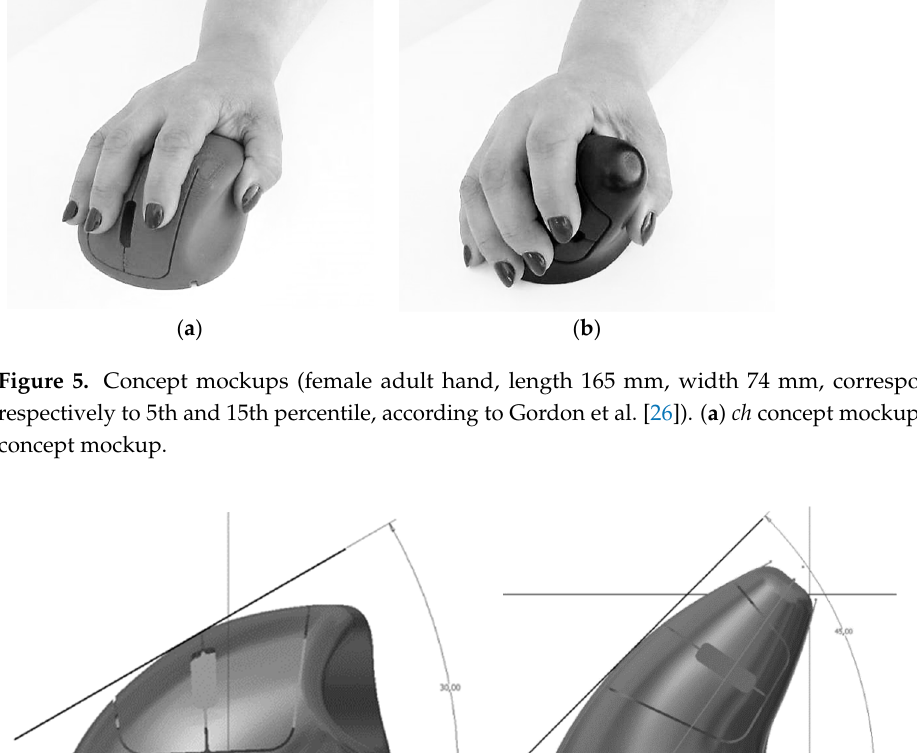
Figure 4. ci concept mockup (male adult hand, length 190 mm, width 88 mm, corresponding respectively to 40th and 50th percentile, according to Gordon et al. [26]).